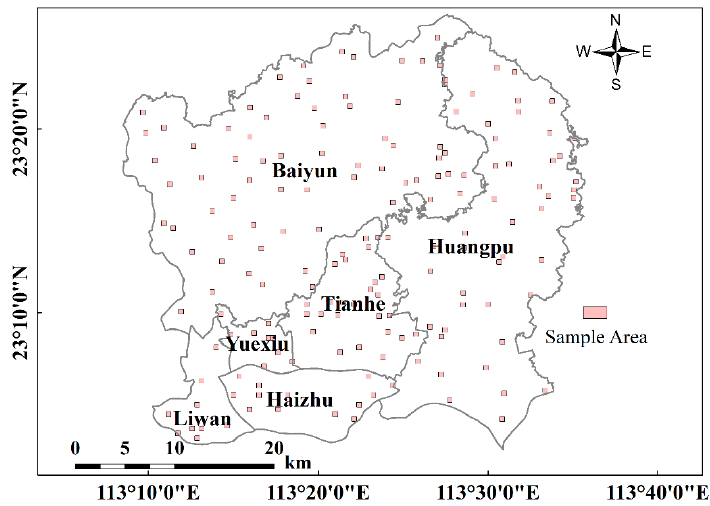
Figure 3. Spatial distribution of the sample areas (shown in pink).